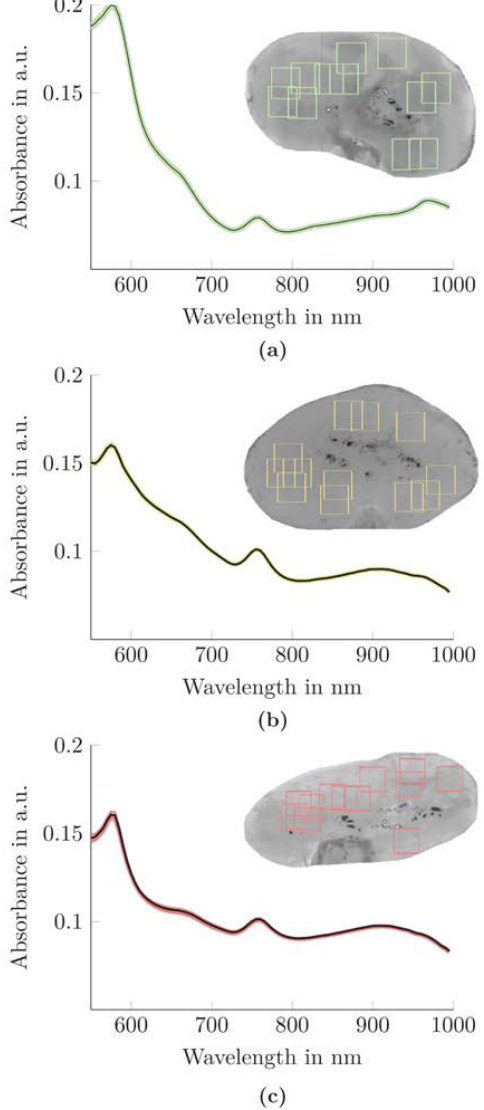
Figure 2. Spectral signature of kidneys with different inulin clearance behavior after 240 min NMP. The mean preprocessed absorbance spectrum of all 12 ROIs of a kidney (shown as a black solid line) and their standard deviation (shown as ( a ) green solid lines for a functional kidney, ( b ) yellow solid lines for a limited functional kidney, and ( c ) red solid lines for a nonfunctional kidney) is presented.